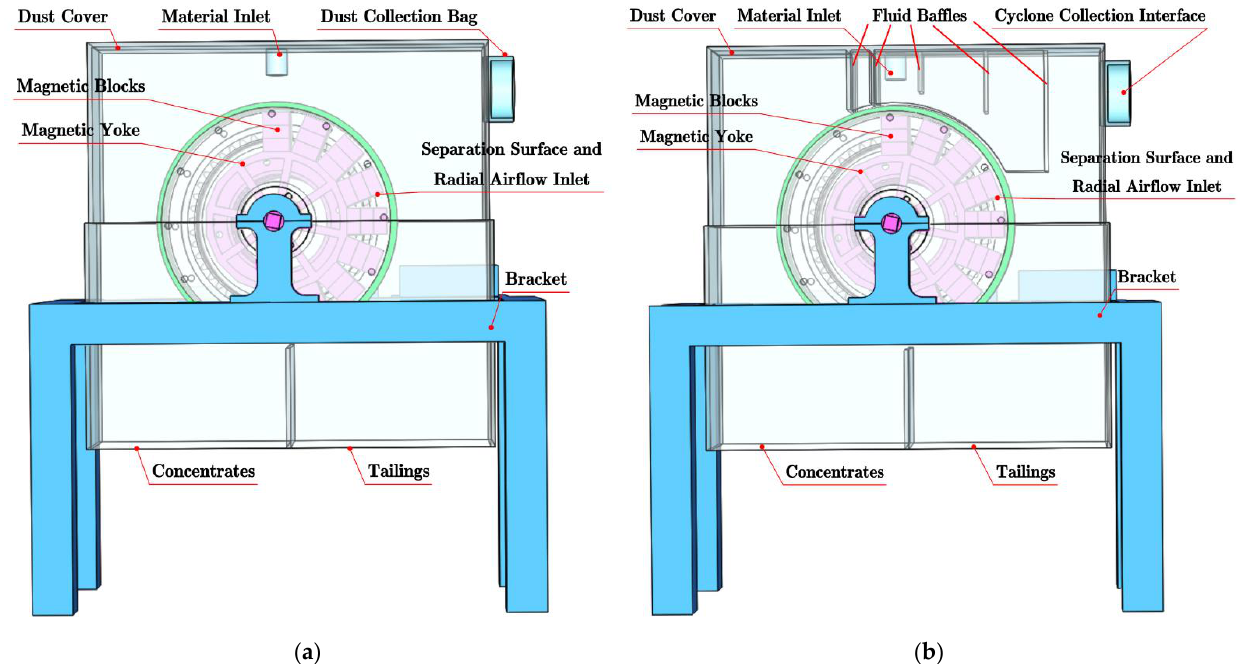
Figure 1. Original ( a ) and improved ( b ) pneumatic drum magnetic separator.